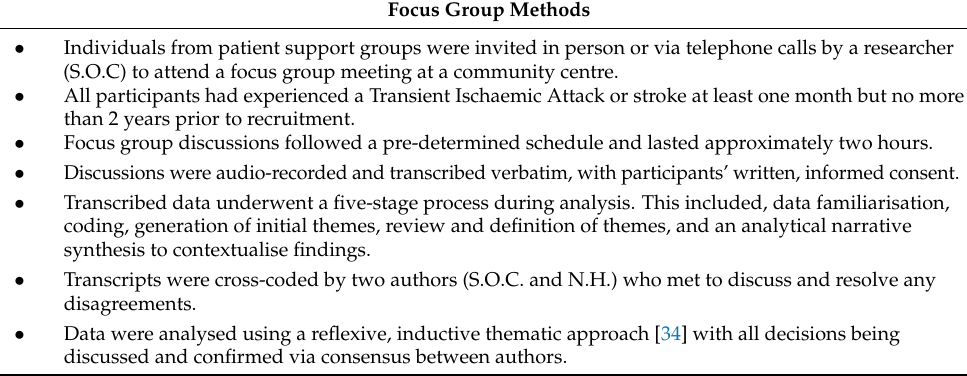
Table 1. Summary of focus group methods used during the development and optimisation phases of the